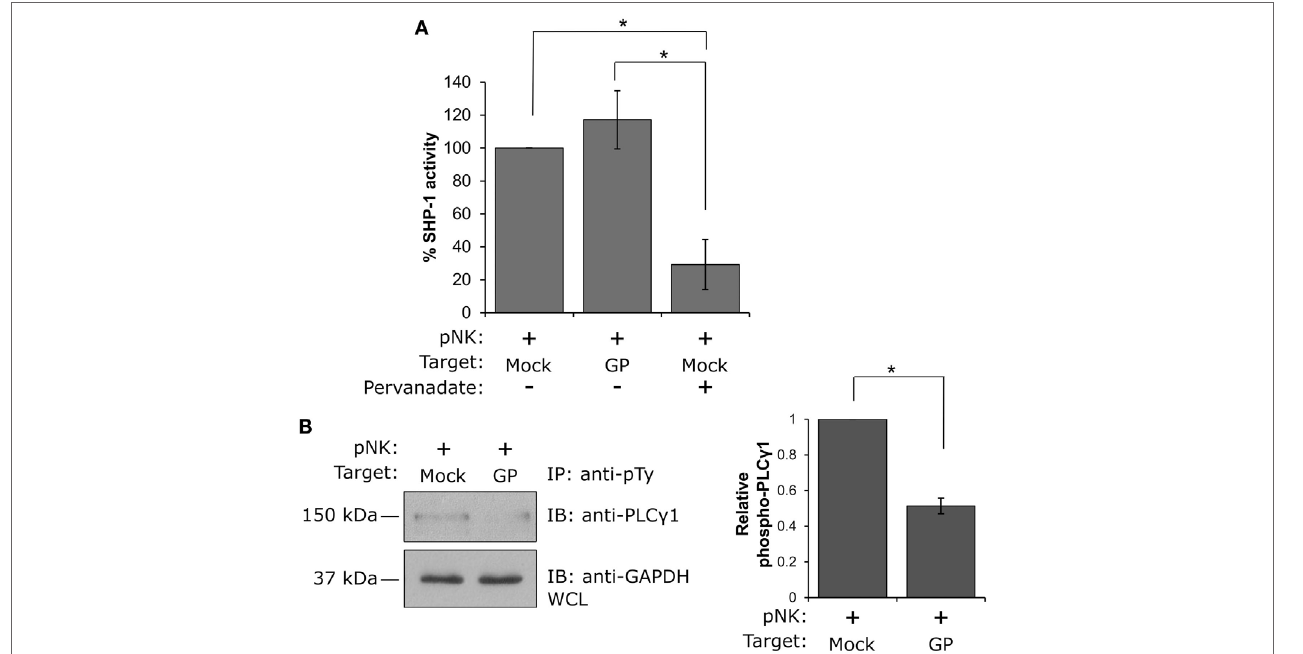
FigUre 7 | Natural killer (NK) cell interaction with GP-expressing cells suppresses NK cell activity by preventing PLC γ phosphorylation and not by promoting SHP-1 activity. (a) Primary NK cells were incubated with mock- or GP-transfected HEK293T target cells at 37°C for 5 min, and SHP-1 activity was determined as described in the Section “Materials and Methods.” NK cell lysis in the presence of the phosphatase inhibitor pervanadate served as a negative control. A bar graph summarizing SHP-1 catalytic activity obtained from three independent experiments is shown. (B) Primary NK cells were incubated with mock- or GP-transfected HEK293T target cells at 37°C for 5 min before lysis. Immunoprecipitation (IP) of phosphotyrosine immunoblotted using anti-PLC γ 1 is shown. Since IP using anti-pTy antibody lacks a precipitation control, as a loading control, whole cell lysates (WCL) were analyzed by Western blotting with anti-GAPDH antibody. PLC γ 1 band intensities from three independent experiments were determined by densitometric analysis and expressed relative to the band intensity of GAPDH. (a,B) Data in the bar graphs are means ± SEM of three independent experiments. Student’s unpaired t -test; * p <